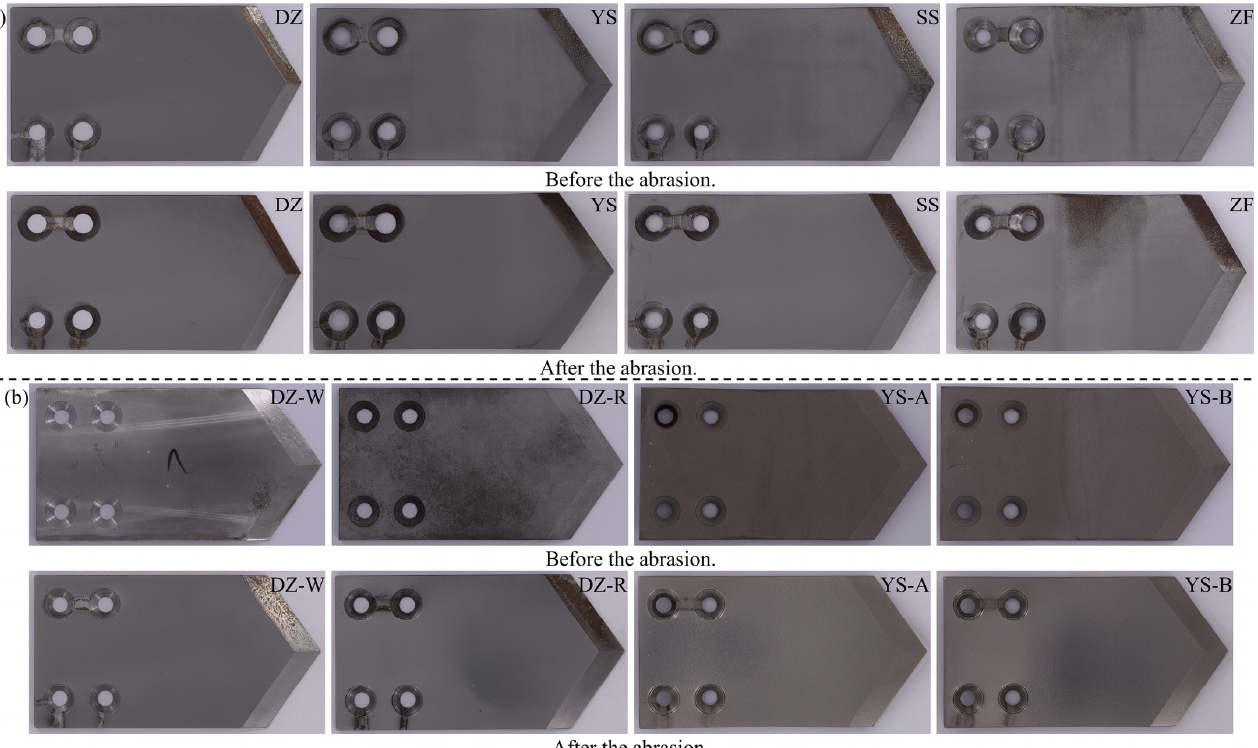
Figure 13. The comparison of PDSs before and after the abrasion. ( a ) PDSs with different macroscopic surface shapes and ( b ) DZ with (DZ-R) and without (DZ-W) heat treatment as well as YS with coating A (YS-A) and coating B (YS-B). DZ-R was sandblasted after heat treatment.